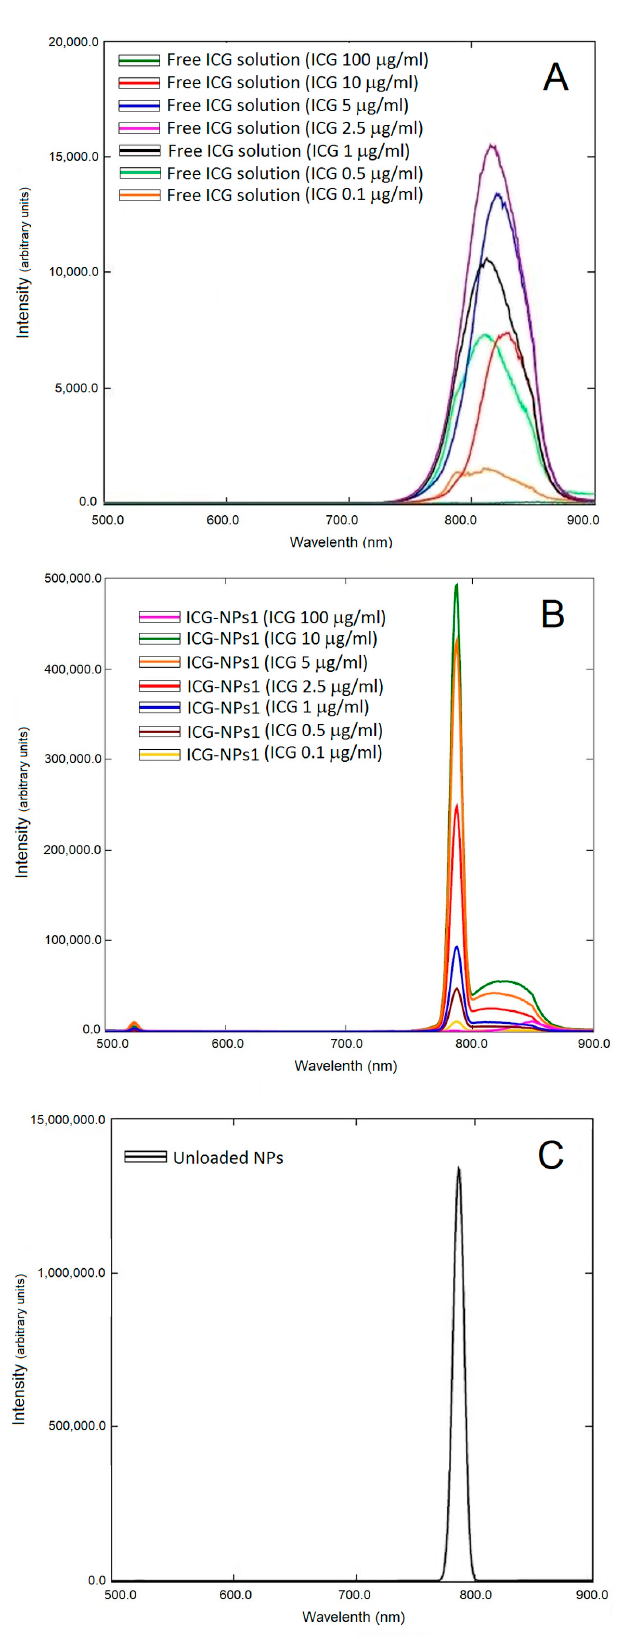
Figure 3. Fluorescence spectra of free indocyanine green (ICG) aqueous solutions ( A ), ICG-NPs1 aqueous dispersions ( B ) (ICG concentrations range 0.1–100 µg/mL), and unloaded nanoparticles (NPs) ( C ).